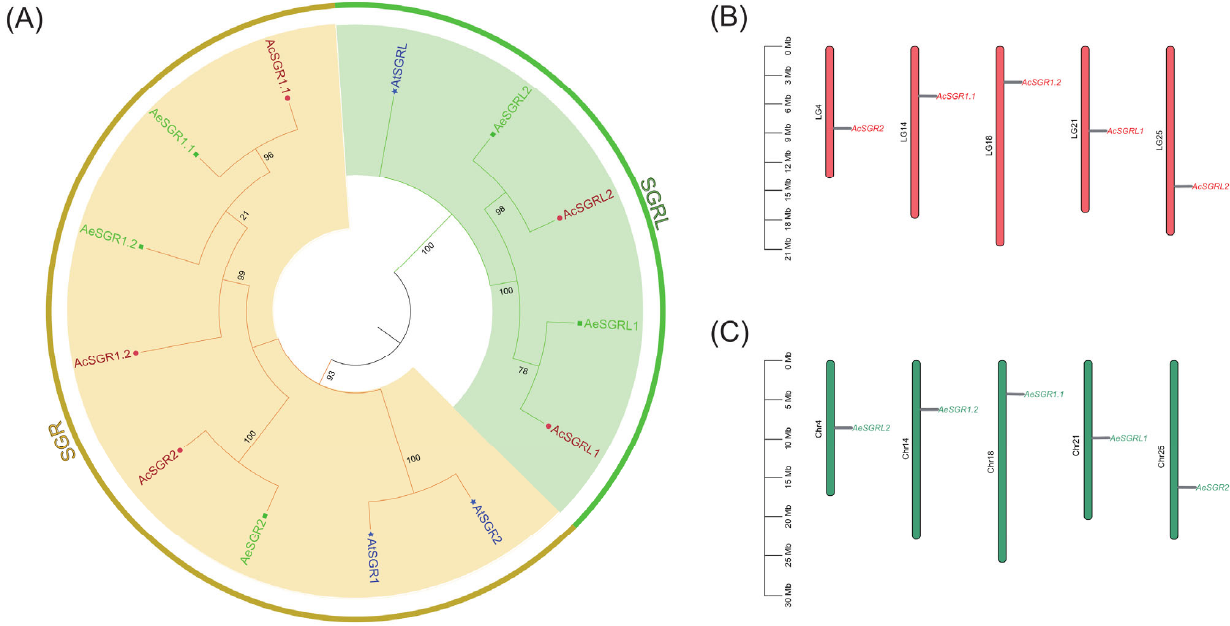
Figure 1. The analysis of SGR superfamily members in kiwifruit. ( A ) Phylogenetic relationships of SGR protein sequences, ( B ) chromosomal distribution of SGR genes in A. chinensis genome, and ( C ) chromosomal distribution of SGR genes in A. eriantha genome. The SGR protein sequences from Arabidopsis thaliana (At) were represented by blue color, those in A. chinensis (Ac) were represented by deep red color, and those in A. eriantha (Ae) were represented by green color. The SGR and SGRL subfamily were highlighted in grey and green colors, respectively.